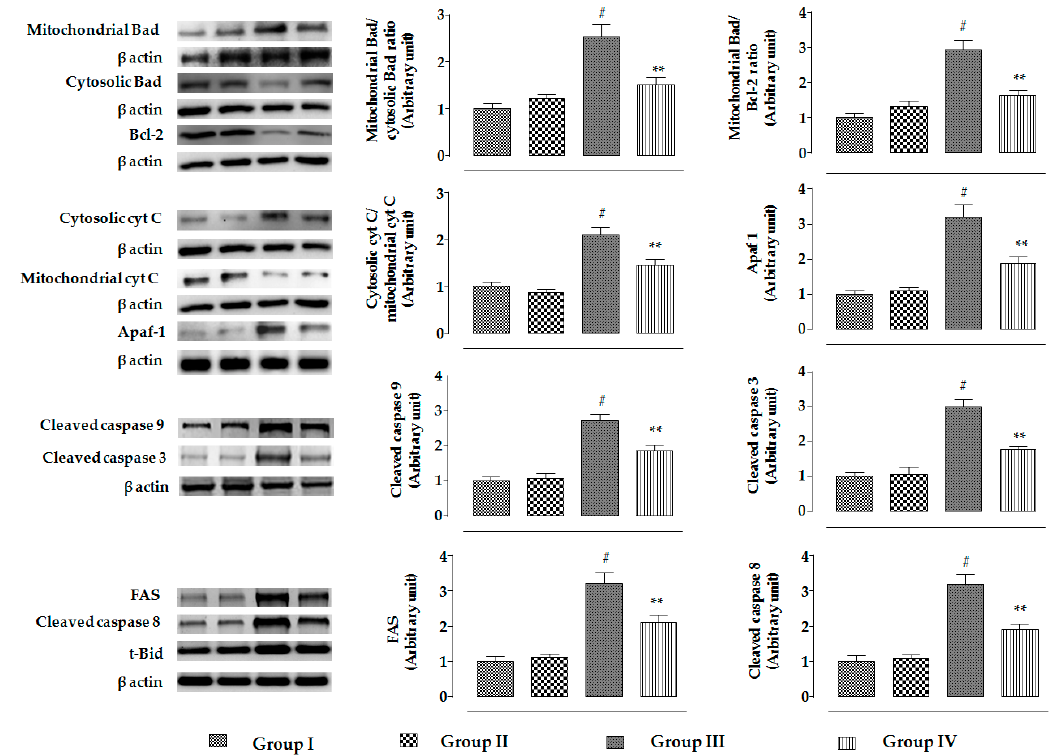
Figure 4. The effects on apoptotic signaling in the absence (CdCl 2 ) and presence of RA (CdCl 2 + RA) in vitro on mouse proximal tubular epithelial cells. The relative band intensities were assessed, and the intensity of the normal control band was assigned as 1. β -Actin served as the loading control. Data are represented as means ± SD, n = 3 (number of plates). # Values significantly ( p < 0.01) di ff er from normal control. ** Values significantly ( p < 0.01) di ff er from CdCl 2 control. Group I: untreated, Group II: RA (40 µ M), Group III: CdCl 2 (40 µ M), and Group IV: CdCl 2 (40 µ M) + RA (40 µ M).